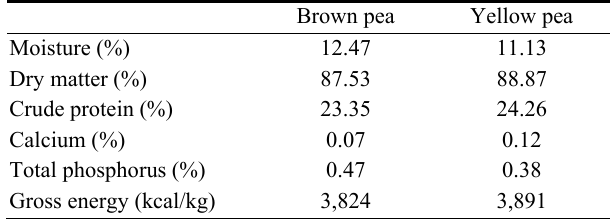
Table 2. Proximate composition of brown- and yellow-seeded pea